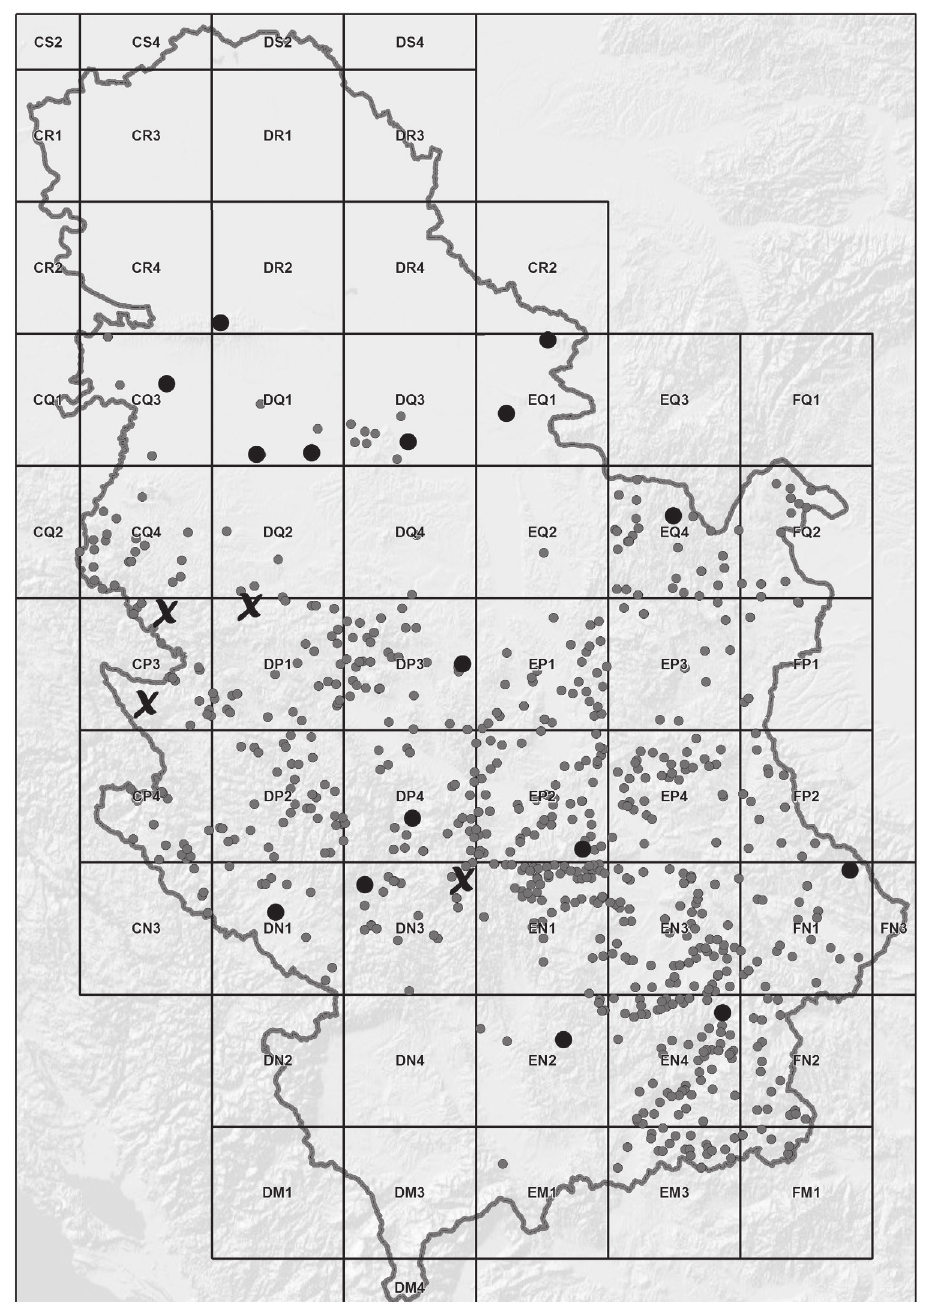
Figure 2. Mushroom research and purchase map . Small dots - points of epigeic mushrooms purchase from the gatherers based on the data obtained from the INCS; big dots - data on epigeic macro fungal diversity existing; X–diversity and ecology data